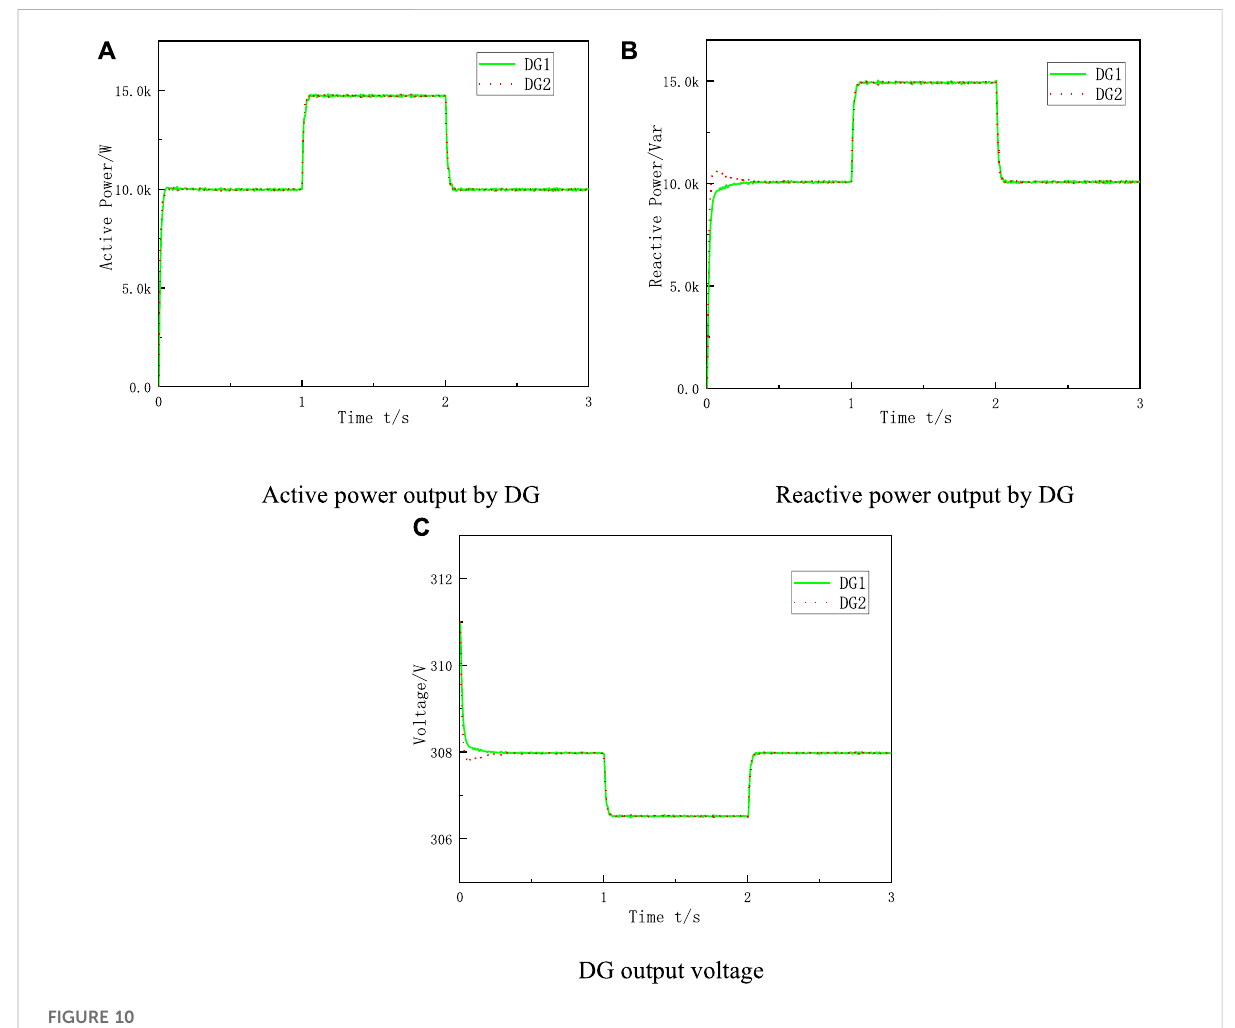
FIGURE 10 SimulationresultsofimproveddroopcontrolwhentwoDGshavethesamecapacity. (A) ActivepoweroutputbyDG. (B) Reactivepoweroutput by DG. (C) DG output